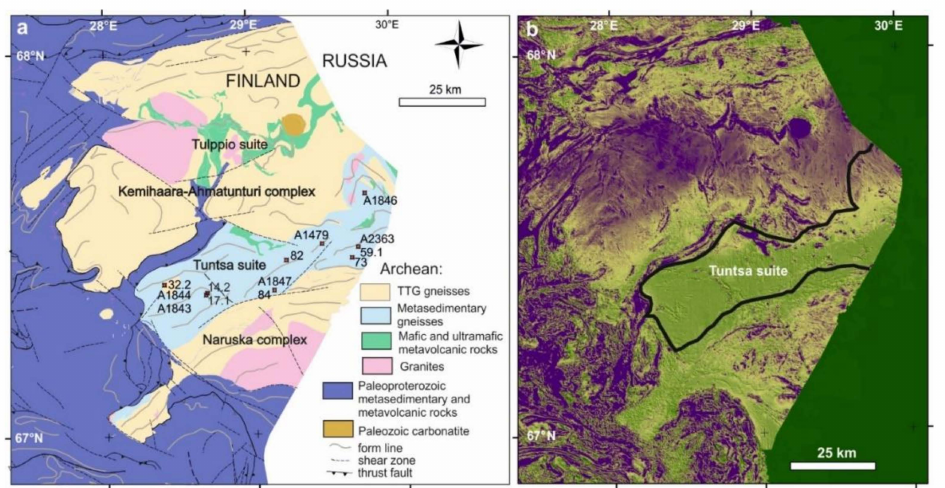
Figure 2. ( a ) Lithological map of the Tuntsa Suite and surrounding areas, simplified from Bedrock of Finland – DigiKP, Digital map database (Electronic resource). Espoo: Geological Survey of Finland (bedrock_of_finland_200k.xml); ( b ) pseudocolour magnetic map, purple = magnetic maximum, green = magnetic minimum, the Tuntsa Suite outlined. In ( a ) the dots with numbers refer to the sites of the studied samples